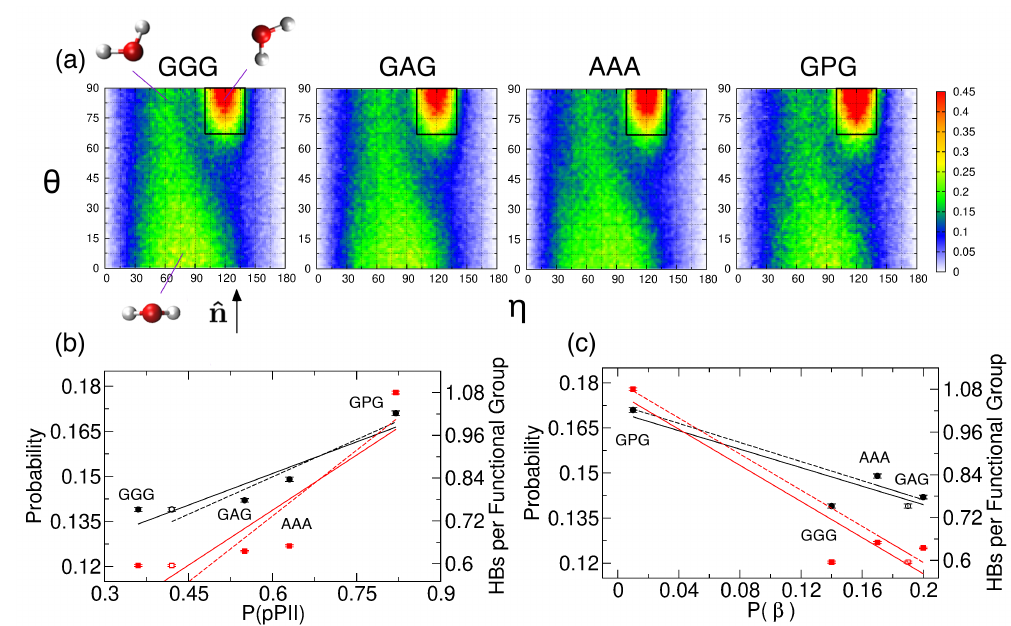
Figure 5. ( a ) Water orientation plots for hydration water adjacent to the backbone of the guest residue of GGG, GAG, AAA, and GPG. The leftmost plot shows three characteristic water orientations with respect to the normal ˆ n to the SAS. The black rectangular region, defined in Section 2.2., contains the most populated water orientations. The color corresponds to the probability density (with scale values multiplied by 10 3 ). ( b , c ) The probability of the most populated water orientation (black solid circles) and the average number of water-guest residue HBs normalized by the number of functional groups (red solid squares) are shown as a function of the ( b ) pPII and ( c ) β populations. The solid black and red lines in ( b ) are a result of a linear regression analysis with Pearson’s r = 0.92 (the probability) and r = 0.86 (the average number of HBs). The solid black and red lines in ( c ) show a result of the regression analysis with r = − 0.89 (the probability) and r = − 0.93 (the average number of HBs). Black and red dashed lines with error bars correspond to the regression analysis performed by using the shifted pPII and β populations for the central glycine residue in GGG (black open circles and red open squares in b and c , respectively). The dashed black and red lines in ( b ) are associated with r = 0.95 (the probability) and r = 0.90 (the average number of HBs). The dashed black and red lines in ( c ) correspond to r = − 0.98 (probability) and r = − 0.99 (the average number of HBs). Table S5 shows the average number of water-peptide HBs for each of the three residues of the four tripeptides. The average number of HBs between water and the guest residue in GGG, GAG, AAA, and GPG (Table S5, Residue 2) normalized by the number of functional groups (two for GGG, GAG, and AAA, and one for GPG) also correlates with the pPII population ( r = 0.86) and anti-correlations with the β population ( r = − 0.93). These correlations again improve ( r = 0.90 and r = − 0.99, respectively) when the pPII and β propensities for the central glycine residue in GGG are replaced by their shifted values (Table S2). The average number of HBs between the water and guest residue does not correlate with the α helix propensity (red solid line in Figure S6, r = 0.35). Tables S6 and S7 show the average number of HBs that water forms with each backbone amide group and